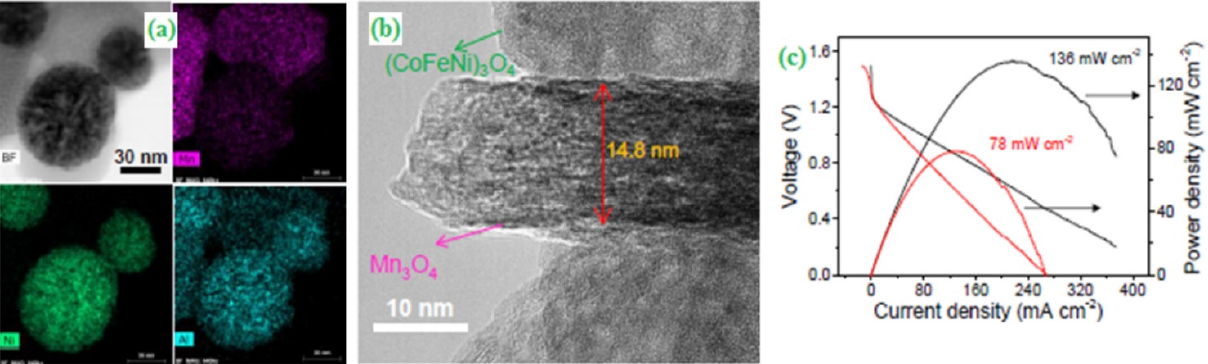
Figure 1. ( a ) Bright–field STEM and EDS mapping of the dealloyed AlFeCoNiMn sample for FeCoNi–based oxide nanoparticles and Mn 3 O 4 nanosheets ( b ) HRTEM image of the Mn 3 O 4 nanosheets in the dealloyed AlFeCoNiMn, and ( c ) Polarization and power density curves of the liquid batteries. Copyright 2020 by American Chemical Society [41].